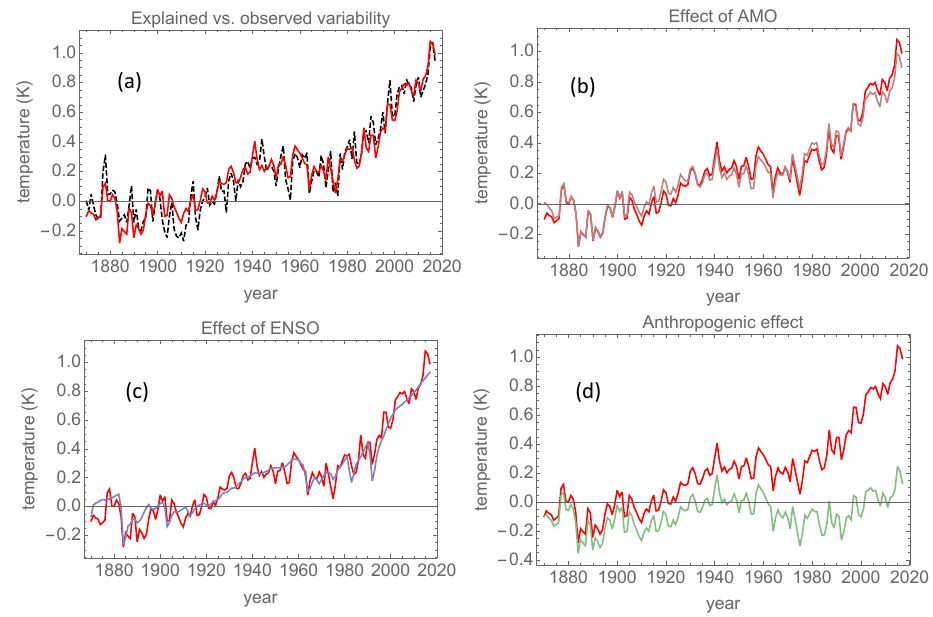
Figure 3. In all four panels, the red curve is the total explained global mean surface temperature (GMST, or the total footprint) from the regression. ( a ) The black, dashed curve is the HadCrut4 GMST signal. ( b ) The brown curve is the signal obtained after the AMO footprint is subtracted from the total footprint. ( c ) The blue curve is the signal obtained after the El Niño Southern Oscillation (ENSO) footprint is subtracted from the total footprint. ( d ) The green curve is the signal obtained after the anthropogenic footprint issubtracted from the total footprint.